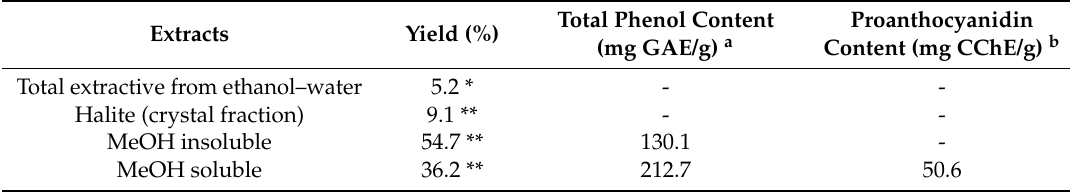
Table 2. Chemical composition of sugar maple bark extracts.